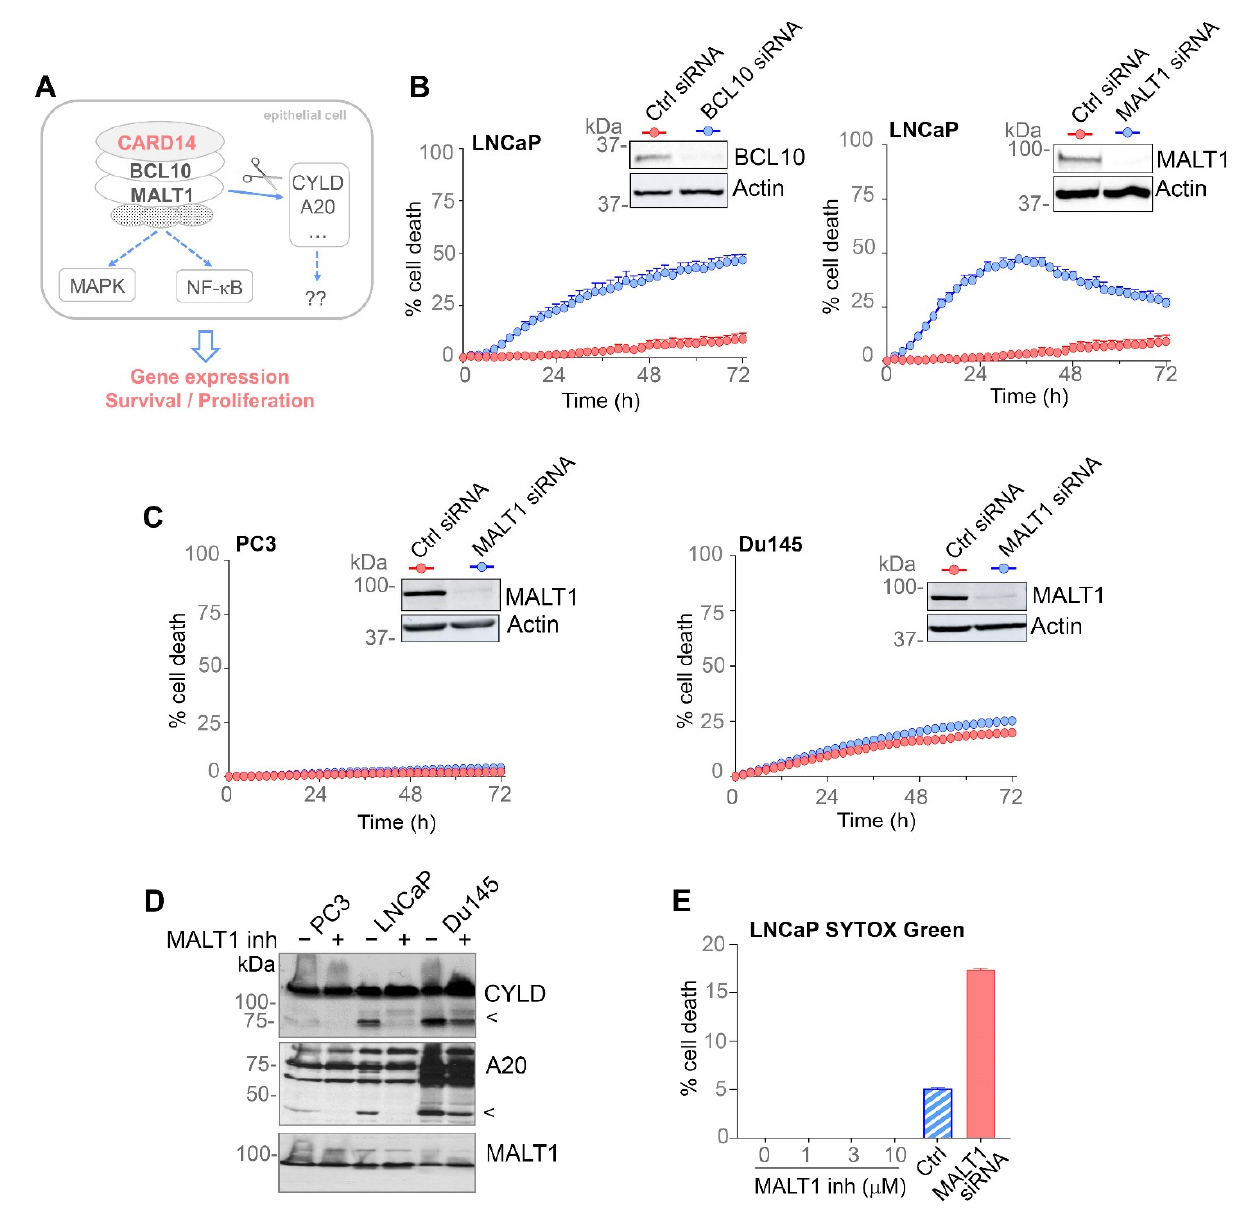
Figure 4. MALT1 protease activity is constitutively active in PCa cells, but PCa cell survival only requires MALT1 scaffold activity and not its catalytic activity. ( A ) Schematic representation of CARD14 signalling in epithelial cells. Activation of CARD14 by a yet to be defined upstream stimulus or a gain-of-function mutation triggers formation of a CARD14–BCL10–MALT1 complex leading to NF- κ B- and MAPK-mediated gene expression. Additionally, CBM formation unlocks the ability of MALT1 to cleave several substrates that further regulate downstream events. ( B , C ) Cell death in function of time upon knock-down of MALT1 or BCL10 in LNCaP cells ( B ), PC3 and DU145 cells ( C ), as indicated. The number of dead cells was quantified using SYTOX green staining and the Incucyte Live-Cell Analysis System. ( D ) The indicated PCa cell lines were left untreated ( − ) or treated (+) with MALT1 inhibitor (1 µM) for 48 h. CYLD and A20 cleavage (indicated with an arrow head), as well as MALT1 expression was visualised by western blot of the corresponding cell extracts. ( E ) Cell death in function of time upon MALT1 inhibition in LNCaP cells, analysed as in ( B ). Results are representative of three independent experiments. Error bars ( B , C , E ) represent means ± SEs.